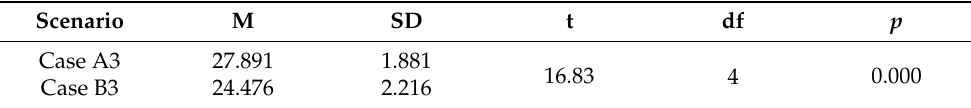
Table 15. Results of the paired sample t -test for scenario